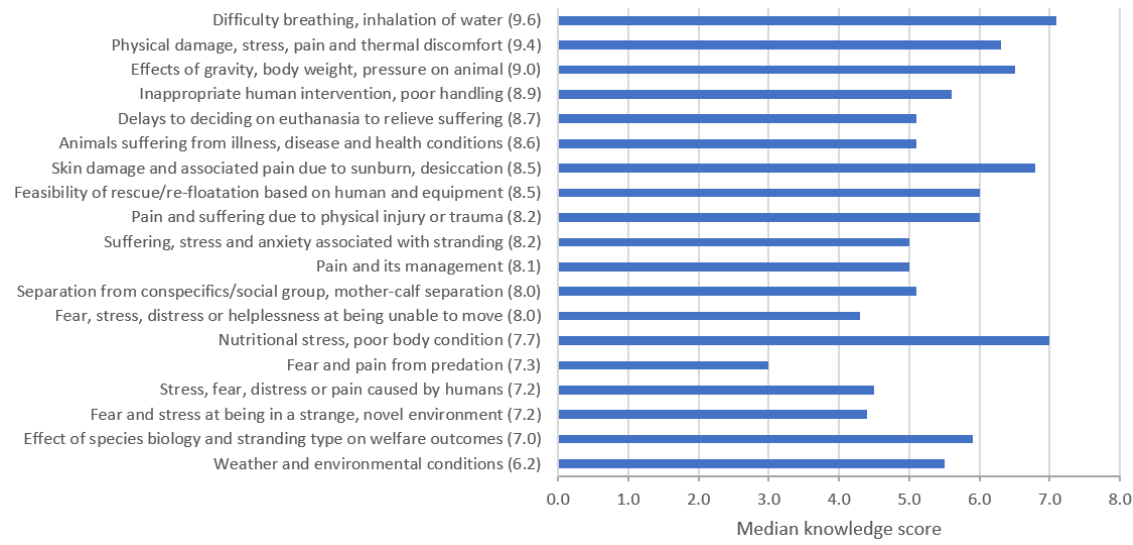
Figure 1. The median scores for the perceived level of knowledge available to assess concern categories about welfare. Ranked in order of the median scores for the perceived severity of the effect of each concern category (in parentheses) on cetacean welfare, arising from participants’ responses on questionnaire 2. Category labels have been reduced to best fit; please refer to Table 3 for full category labels.